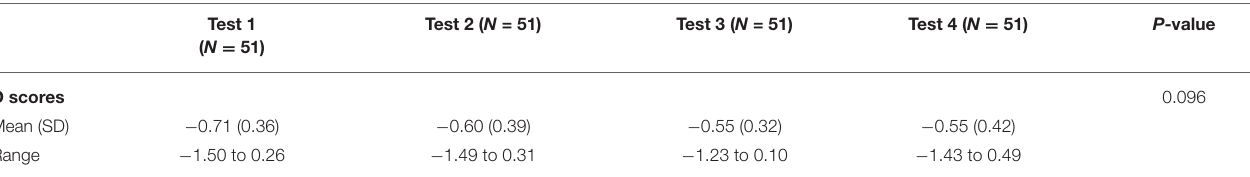
TABLE 7 | D scores representing implicit preferences vs. test